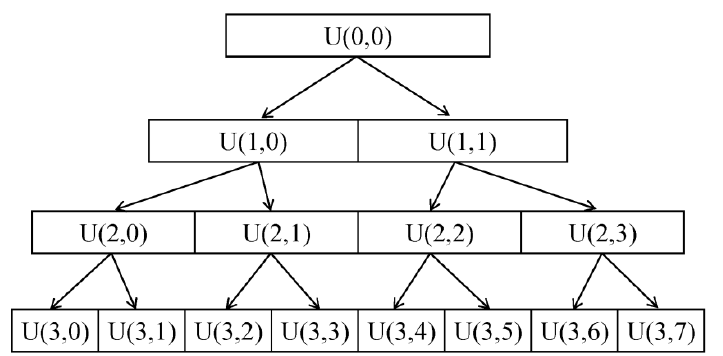
Figure 1. Full WPT binary